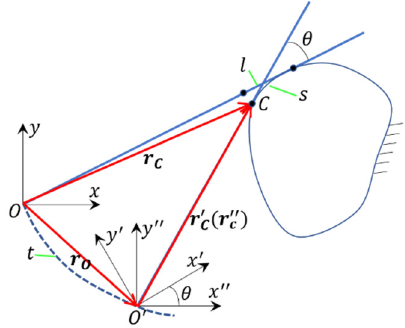
Figure 2. Kinematic analysis of the involute joint.